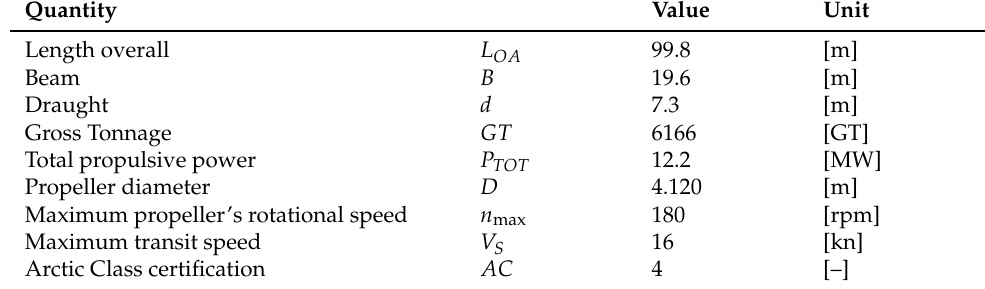
Table 2. Main specifications of the icebreaker CCGS Henry Larsen.